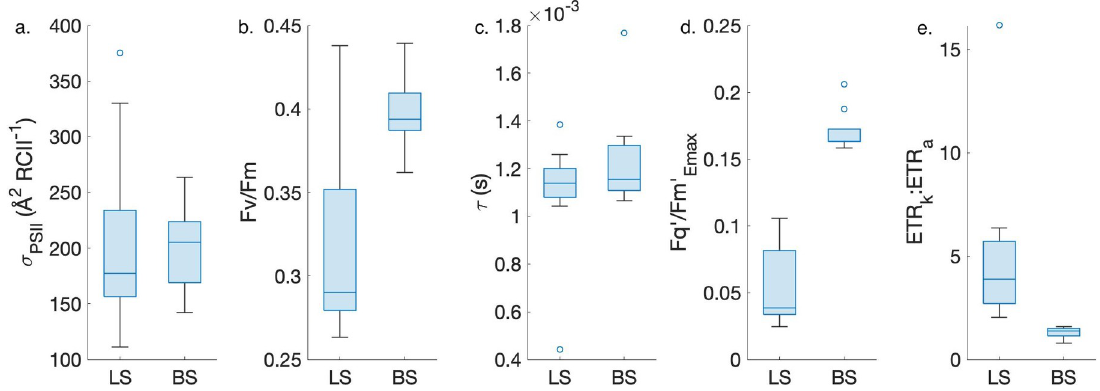
Fig 8. Parameters contributing to the ETR k :ETR a ratio measured in Lancaster Sound (LS) versus Barrow Strait (BS). Horizontal lines within each boxplot represent the median. The upper and lower edge of each box demarks upper and lower quartiles, respectively, while whiskers extend over the entire data range, excluding outliers. Outliers, determined as data points falling over 1.5x the interquartile distance away from box edges, appear as unfilled circles. p values in each subplot are results from 2-group Kruskal-Wallis tests. All data shown here was collected during the 25 reprocessed P-I